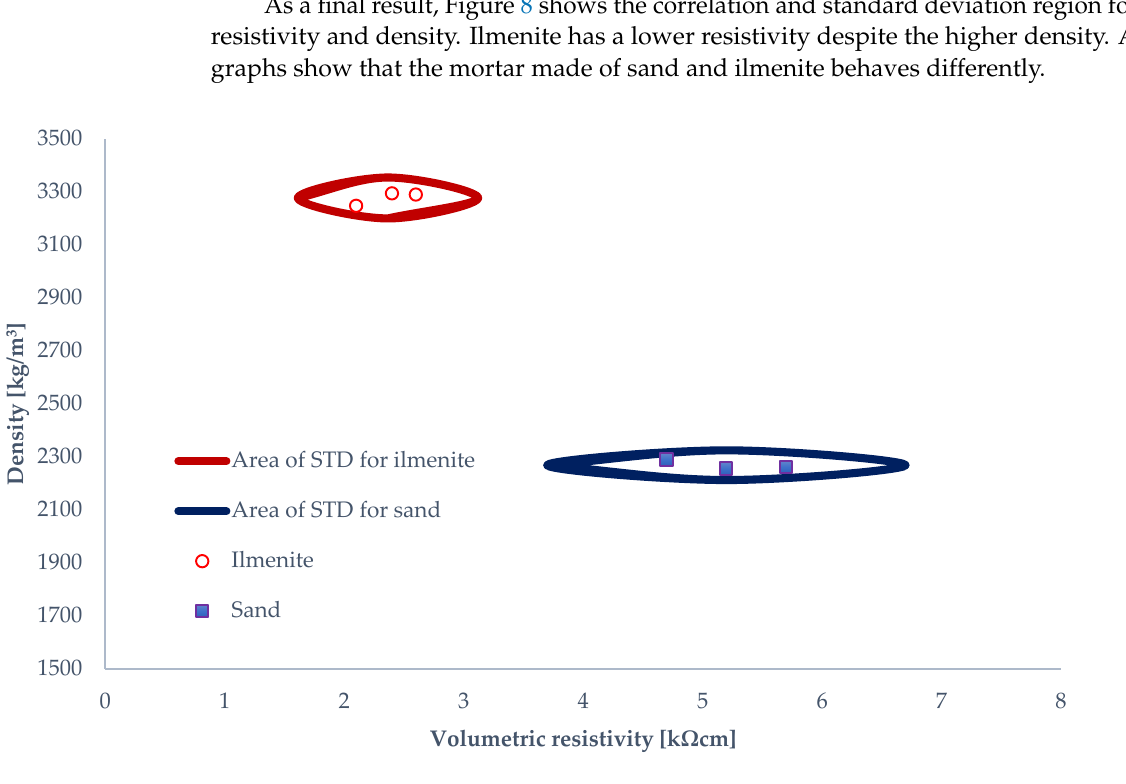
Figure 8. Correlation between the values of volumetric resistivity and density.